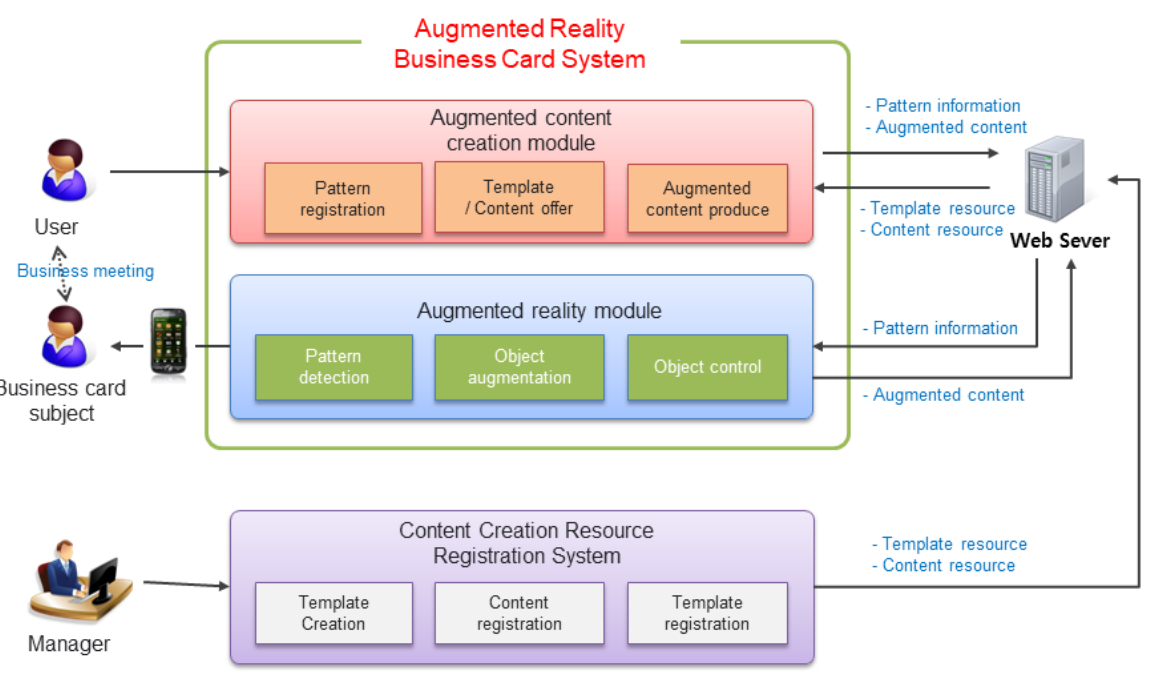
Figure 5. Configuration diagram of participatory Augmented Reality business card information sys- tem.